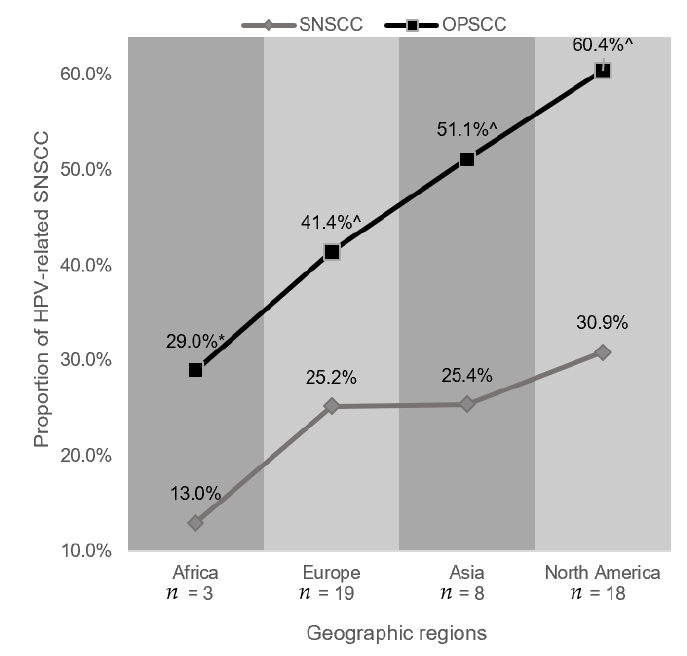
Figure 3. HPV prevalence in sinonasal squamous cell carcinoma (SNSCC) stratified by geographic region for oropharyngeal squamous cell carcinoma (OPSCC) and SNSCC demonstrating paired prevalence rates using the random-effects model. Studies from India and Japan were removed from the Asian SNSCC data as they were felt to introduce bias as these counties were not represented in the OPSCC data. * Source: Jalouli et al., (2010) [84] and Jalouli et al., (2012) [85]. ^ Source: Ndiaye et al., (2014) [86].